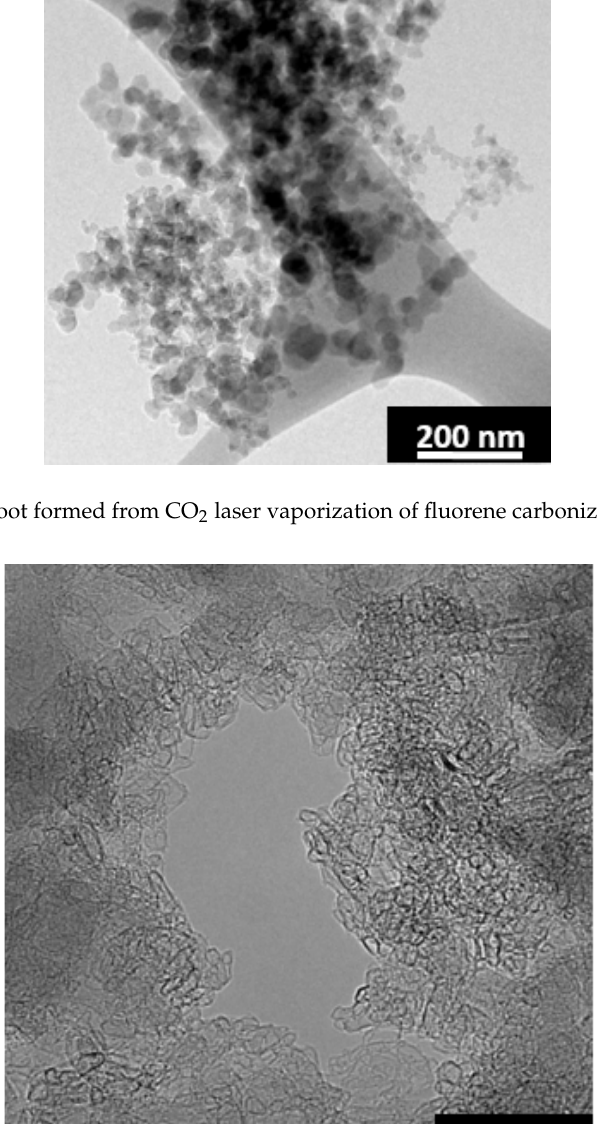
Figure 9. TEM micrograph of pore wall from anthracene-fluorene derived porous graphite.